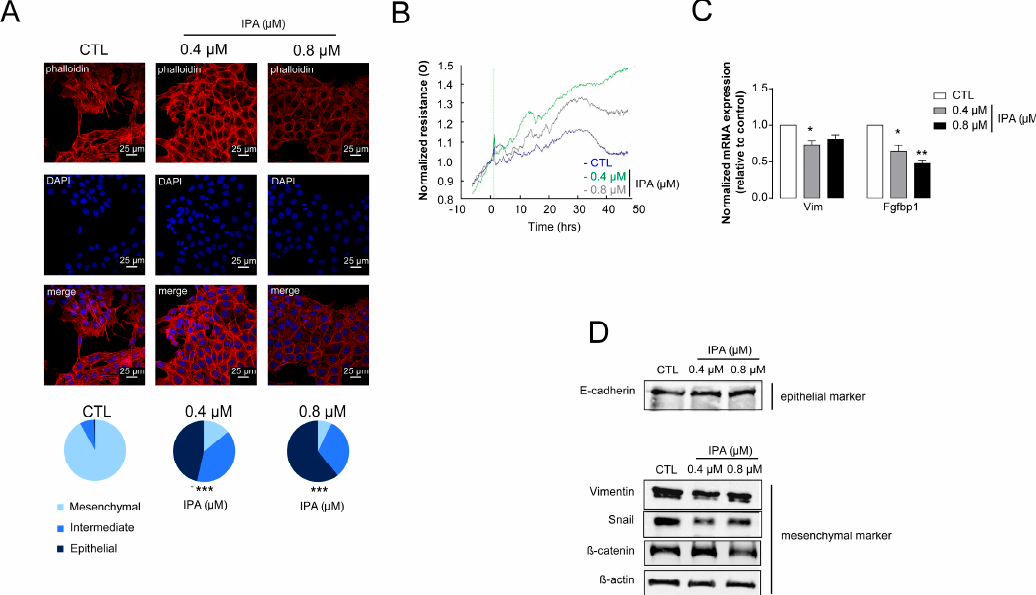
Figure 4. Indolepropionic acid (IPA) induced mesenchymal-to-epithelial transition (EMT). 100,000 cells / well 4T1 cells were treated with IPA in the concentrations indicated for 24 h; then, ( A ) cellular morphology was observed using Texas Red-X Phalloidin and DAPI staining (representative figure, n = 3). Scale bar corresponds to 25 µ m. Mesenchymal cells are characterized by stress filaments that are absent in epithelial cells; for details on morphology, see [27] and Figure S3. ( B ) Normalized resistance was measured in electric cell–substrate impedance sensing (ECIS) impedance-based experiments (representative figure, mean ± SD, n = 1). ( C , D ) In IPA-treated 4T1 cells, the expression of the indicated genes were determined in ( C ) RT-qPCR (n = 3) and ( D ) Western blotting ( n = 3). β -actin was used as a loading control. For Western blots, a typical experiment was displayed. Fold data were log2 transformed to achieve normal distribution. A statistical significance was determined using the ANOVA test followed by Dunnett’s post-hoc test, except for panel D, where a chi-square test were conducted. *, ** and *** indicate statistically significant di ff erence between control and treated samples at p < 0.05, p < 0.01 or p < 0.001, respectively. Abbreviations: Vimentin (Vim), fibroblast growth factor-binding protein1 (FgfBp1), snail family transcriptional repressor-1 (Snail) and β -catenin) E-cadherin, zonula occludens-1 (ZO1).